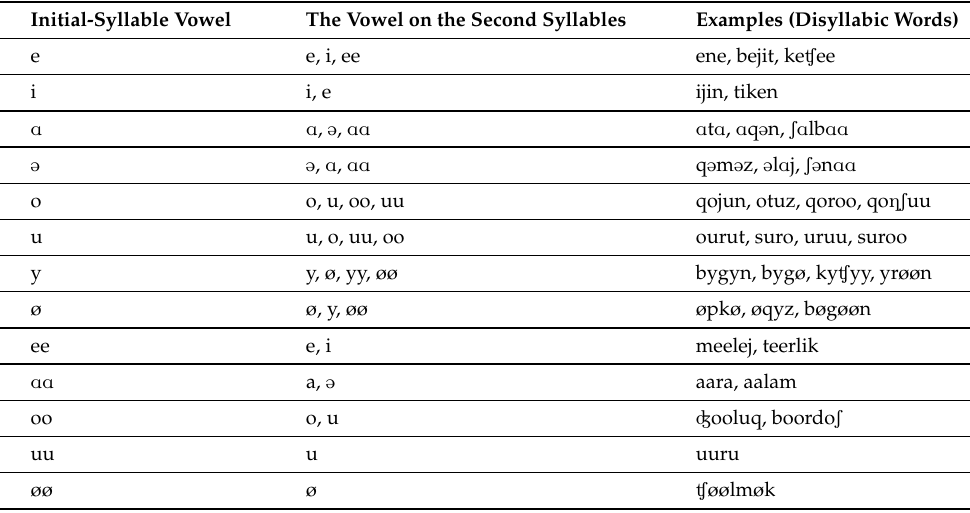
Table 4. The combinations of vowels in harmonic disyllabic words in Kirghiz.